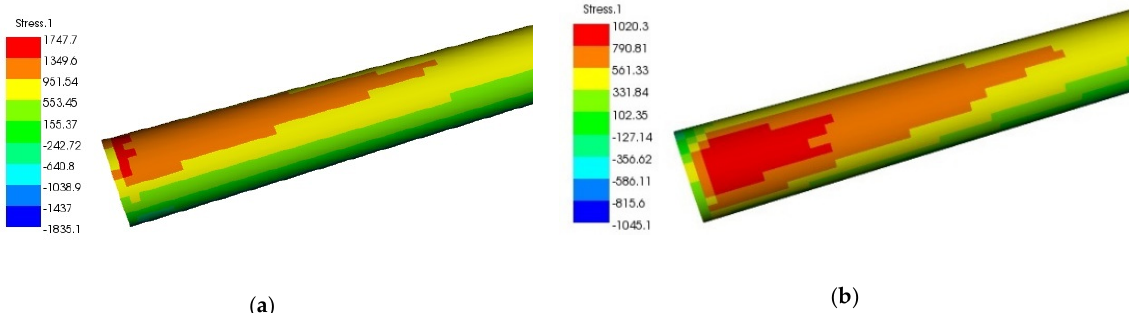
◦ angle; ( b ) stress fiber in 30 ◦